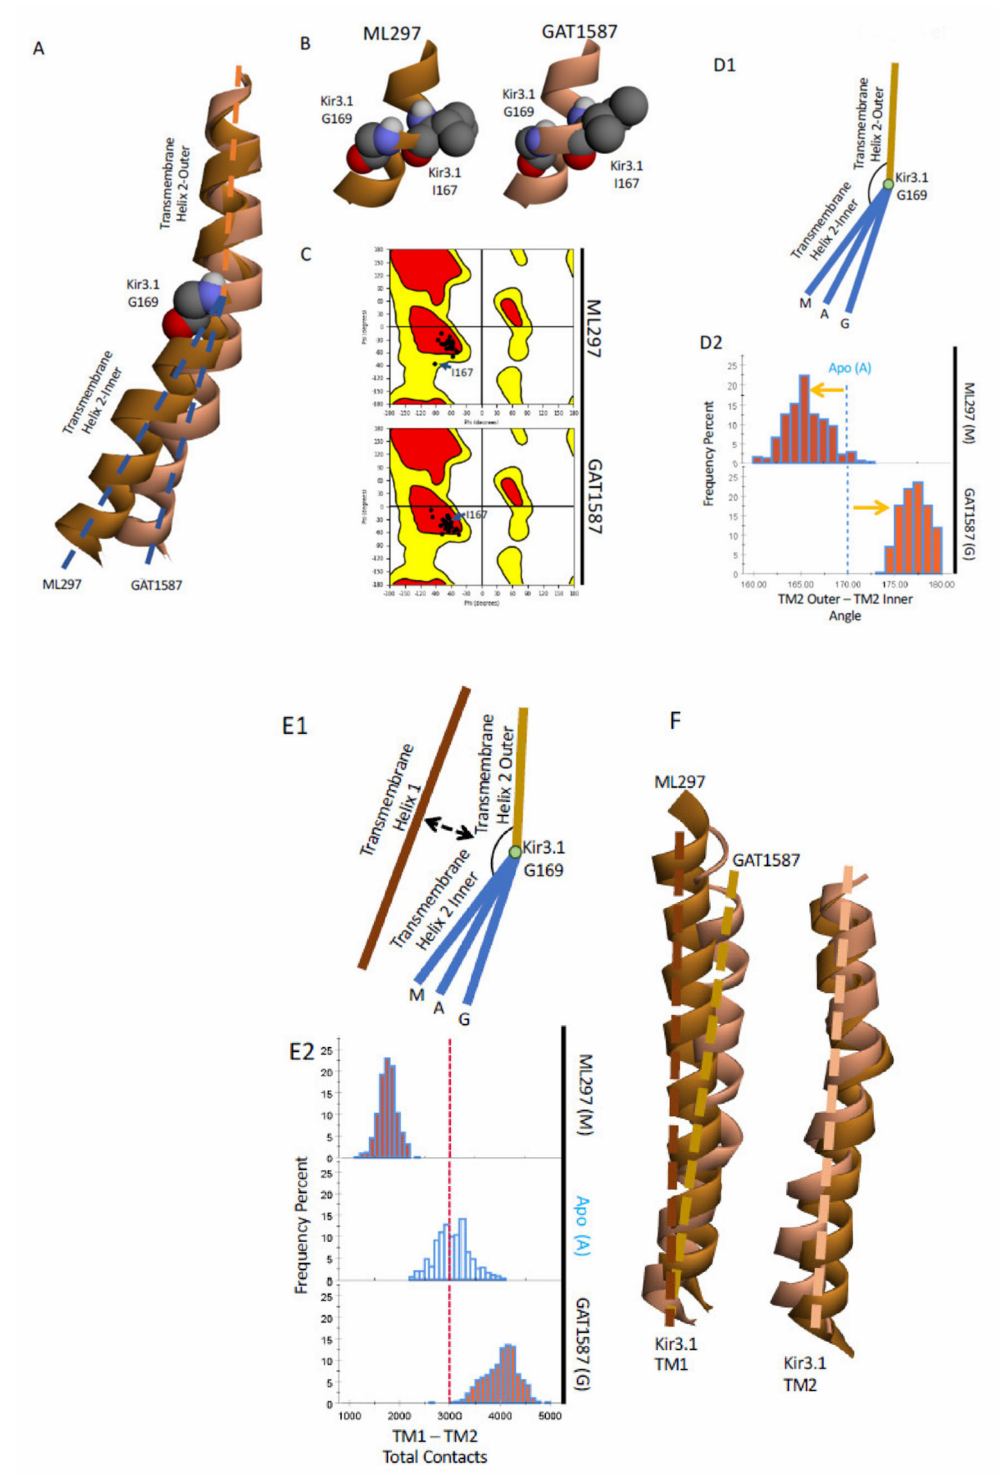
Figure 3. ML297 decreases and GAT1587 increases the angle between the outer and inner TM2 segments on each side of the flexible GIRK1-G169. ( A ) Comparison between TM2 of the ML297 (dark orange) and the GAT1587 (light orange) complexed with the GIRK1/2 systems. ( B ) The two hinge points that allow for TM2 bending. ( C ) Ramachandran plots for residues within TM2. I167 is highlighted in both. ( D ) Schematic representation of the movements of TM2 and a quantification of the bending around GIRK1-G169. ( E ) Expanded model including the nearby TM1 and a quantification of these effects. ( F ) Relative movements of the two transmembrane